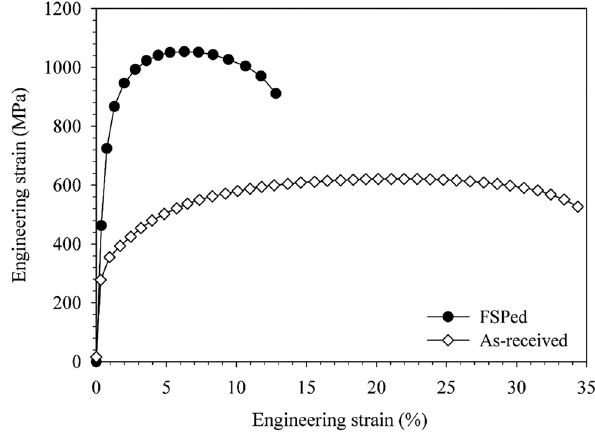
Figure 3: Engineering strain – engineering stress curves of AR and FSPed DP600 steel.